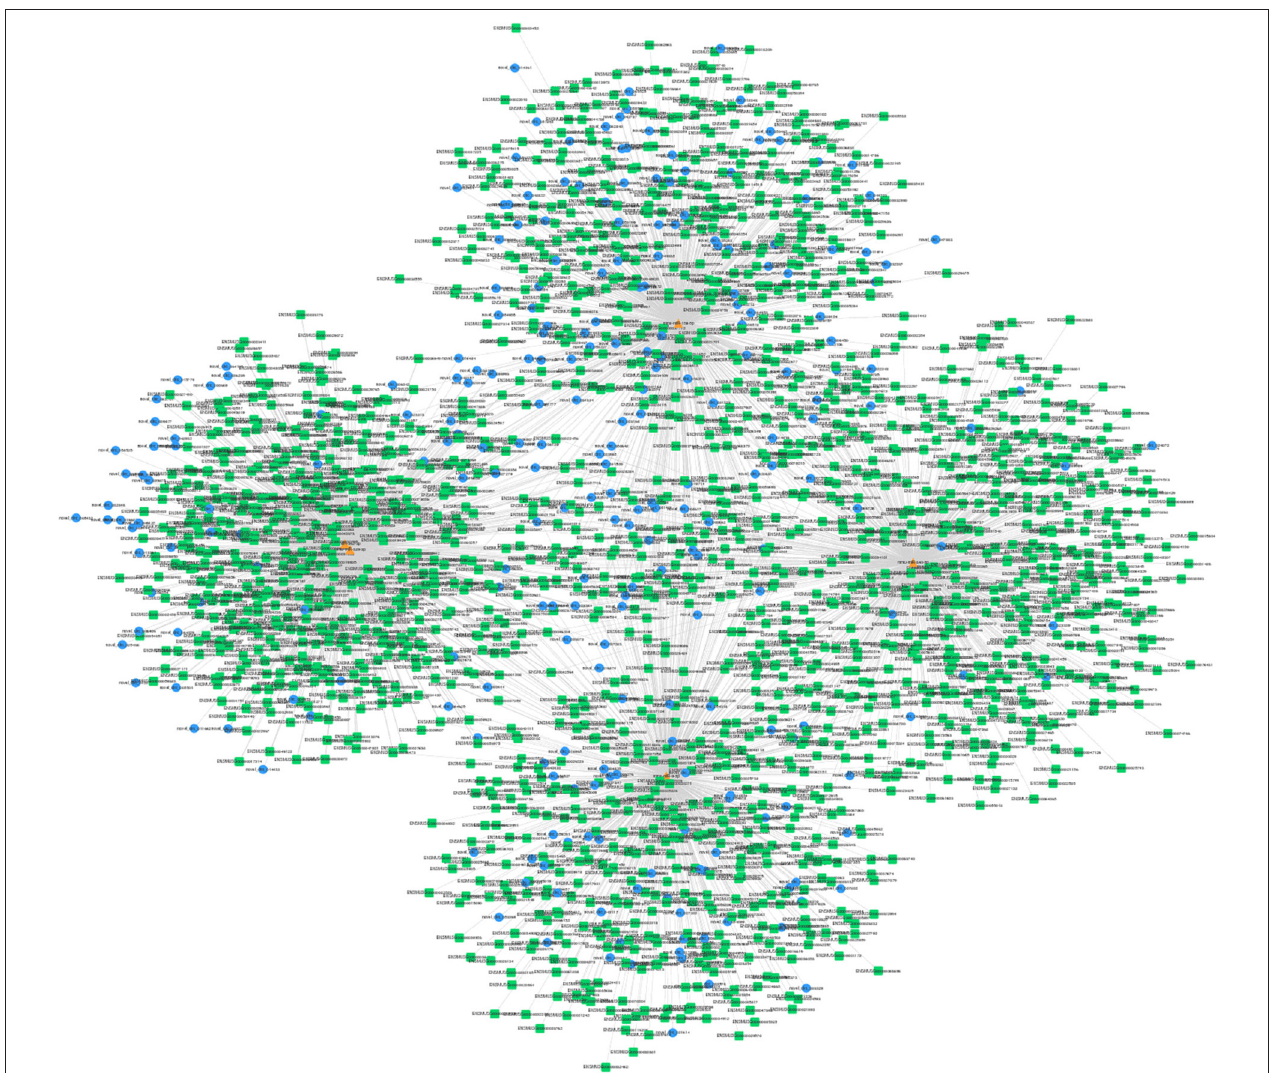
FIGURE 4 | Top 5 miRNA-related circRNAs-miRNA-mRNA ceRNA network. Circular blue, triangular orange, and square green nodes represent circRNAs, miRNAs, and mRNAs, respectively.